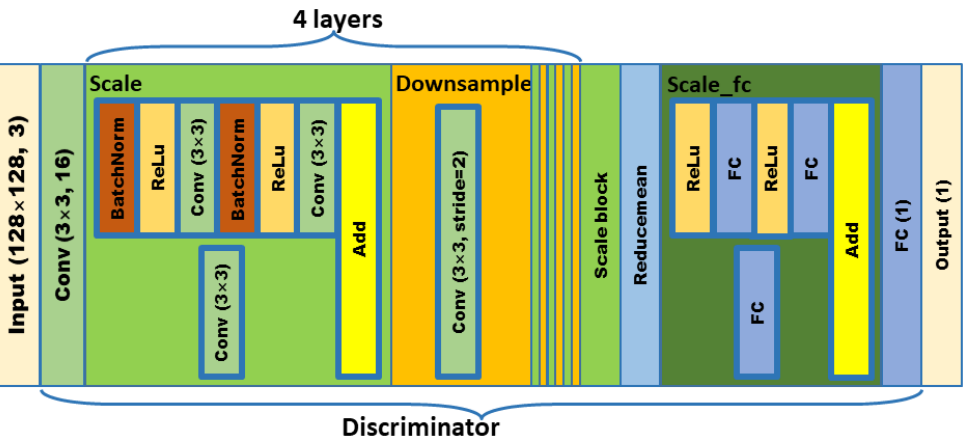
Figure 6. Discriminator network. Table 3. Output size of the layer in the discriminator network.